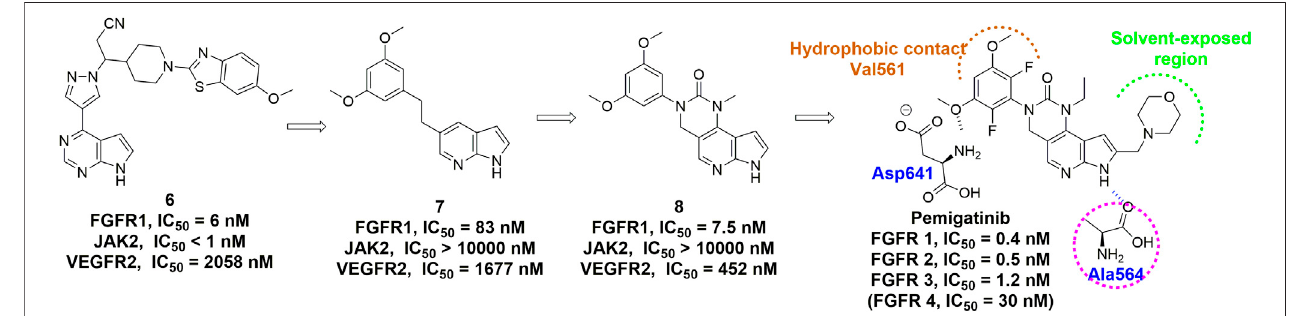
FIGURE 8 | Discovery of pemigatinib and summary of interactions of pemigatinib and FGFR1 ATP binding site. H-bonds are indicated by blue hashed lines. Hydrophobic interactions are outlined by hashed brown arc. Solvent-exposed region is highlighted using green